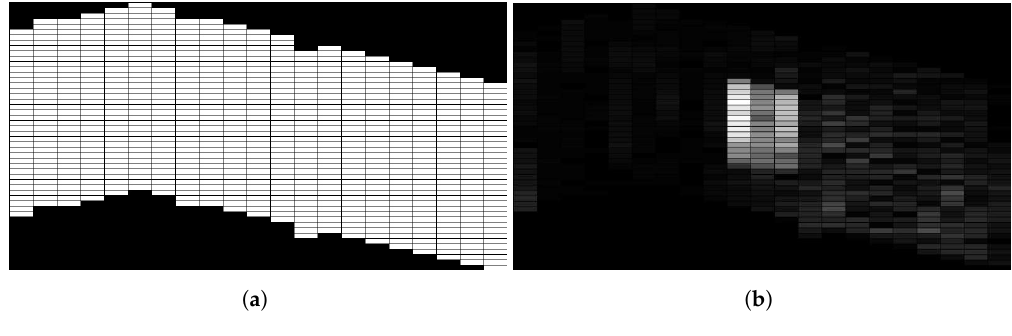
Figure 10. Results with Imperfect V-Shape Scan. ( a ) Imperfect V-shape Scan Coverage; ( b ) Processing